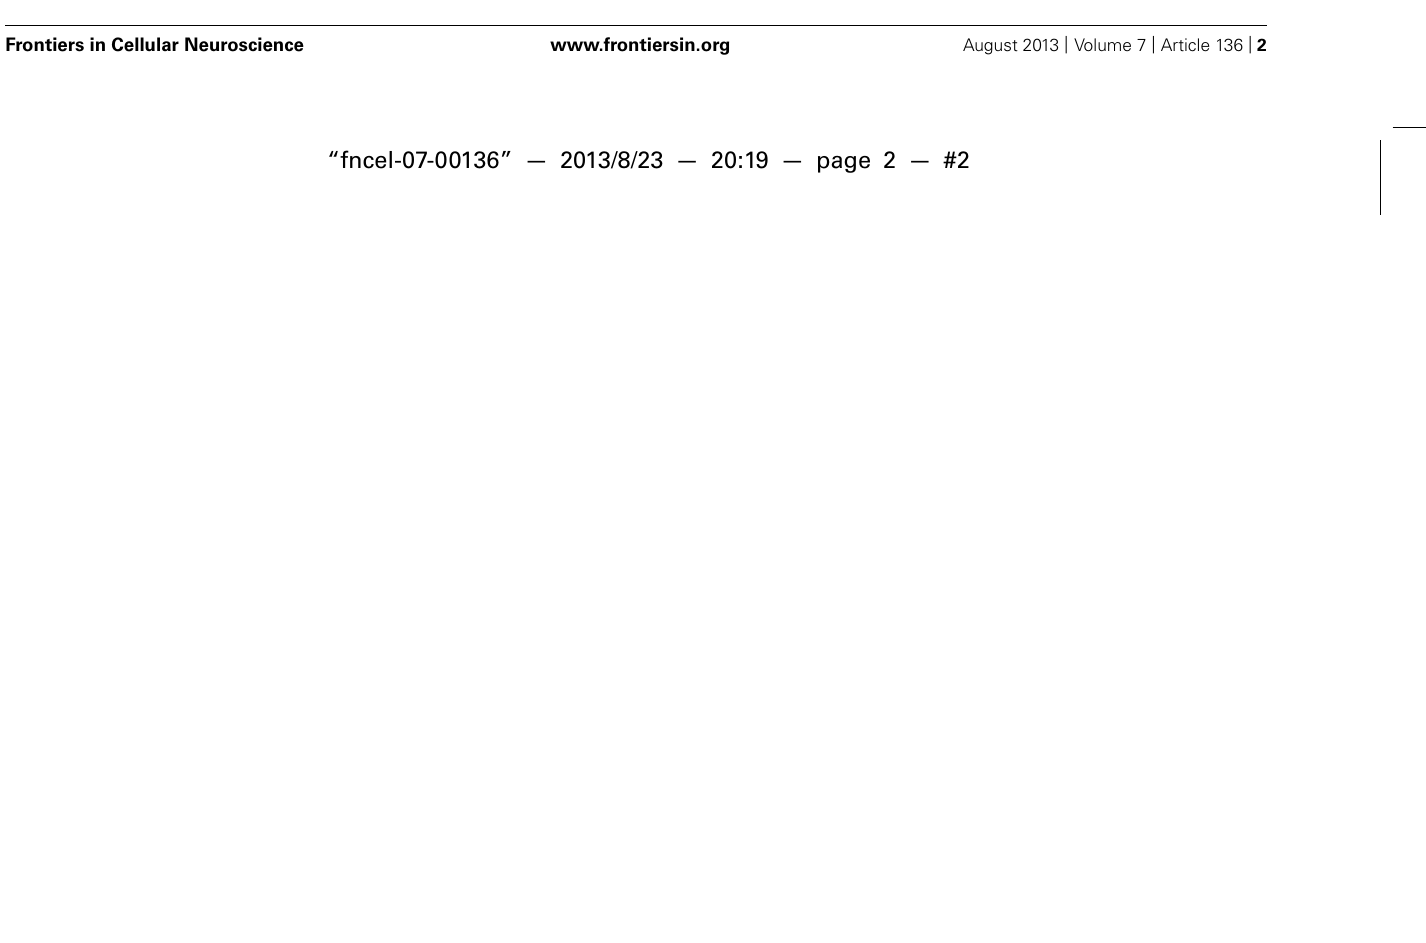
been shown to promote spine maturation (right). Colored dots next to miRNA indicate the target(s) of each miRNA shown to modulate plasticity. See text for details on individual miRNA